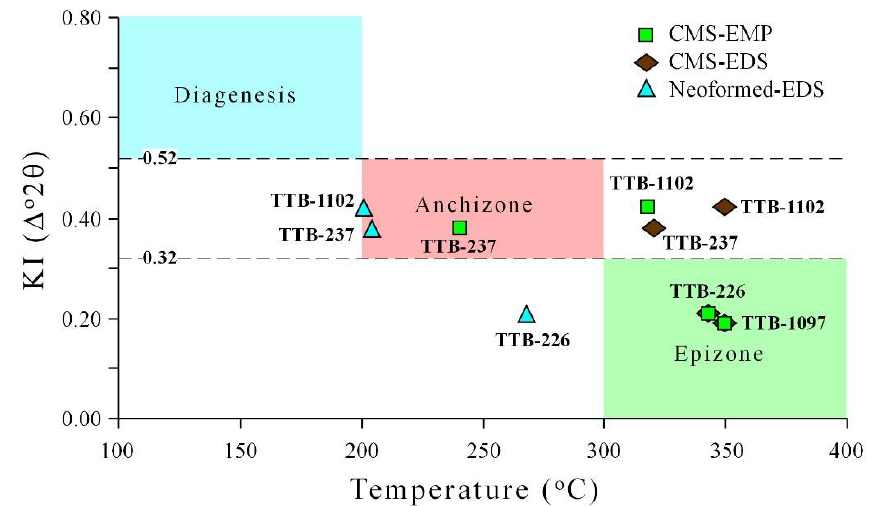
Figure 14. Chlorite thermometry data versus illite Kübler index data of the samples. The Diagenesis–Anchizone–Epizone regions are drawn based on assumed temperature limits for low and upper limits of anchizone [2,7–9].